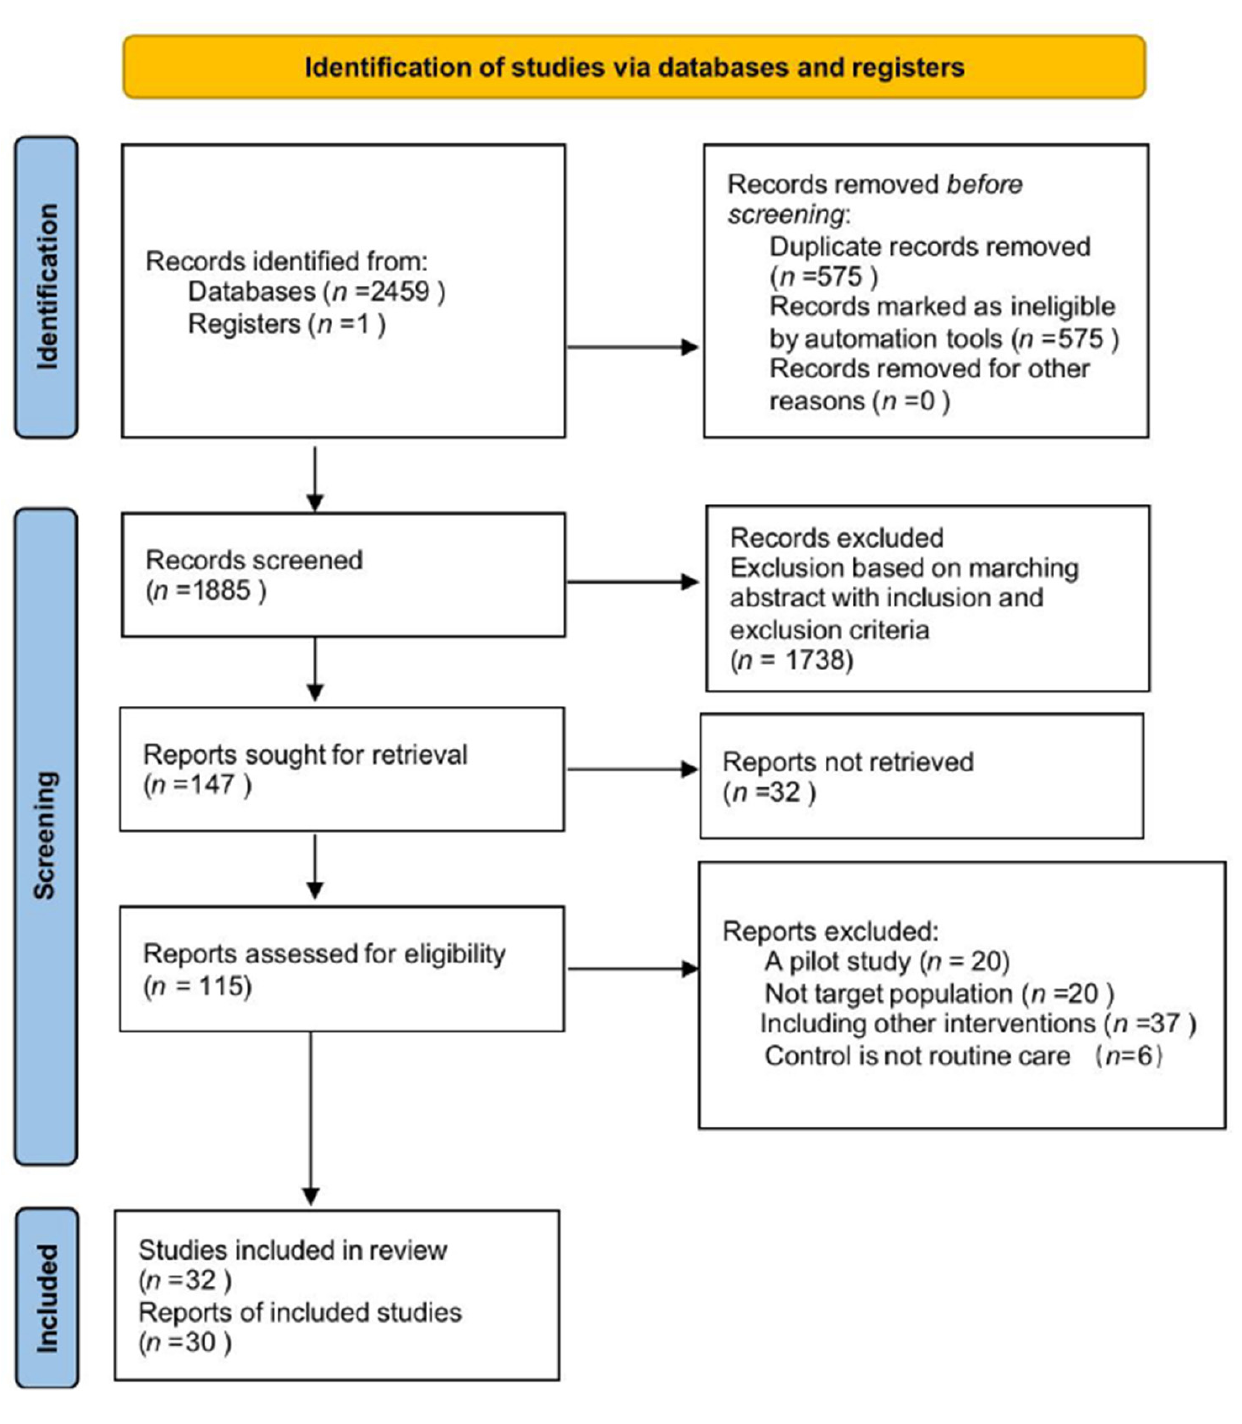
Figure 1. Flow diagram of preferred reporting items for systematic reviews and